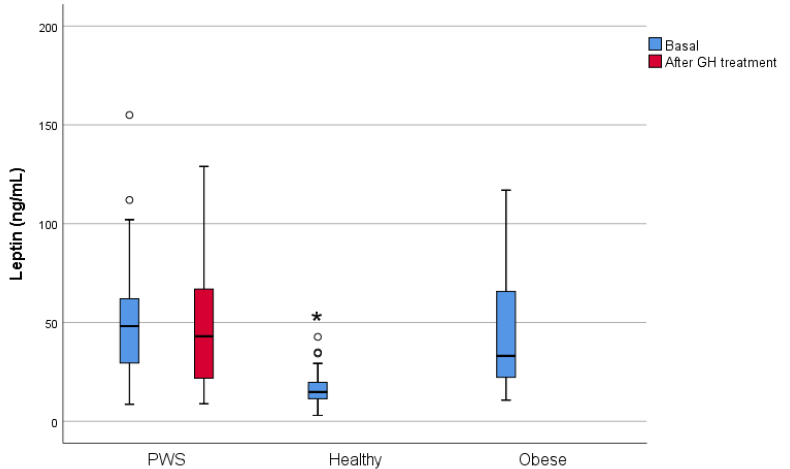
Figure 2. Leptin levels at baseline in the three groups (blue) and after GH treatment in PWS (red).* p < 0.001 Differences in baseline leptin levels between the three groups (Kruskall–Wallis test). Leptin levels did not change in Prader–Willi subjects after GH treatment (Willcoxon signed-rank test, p = 0.144). Outliers are represented as circle symbols. Table 2. Anthropometrics, body composition, and plasma hormone levels in patients with PWS before and after 12 months’ growth hormone